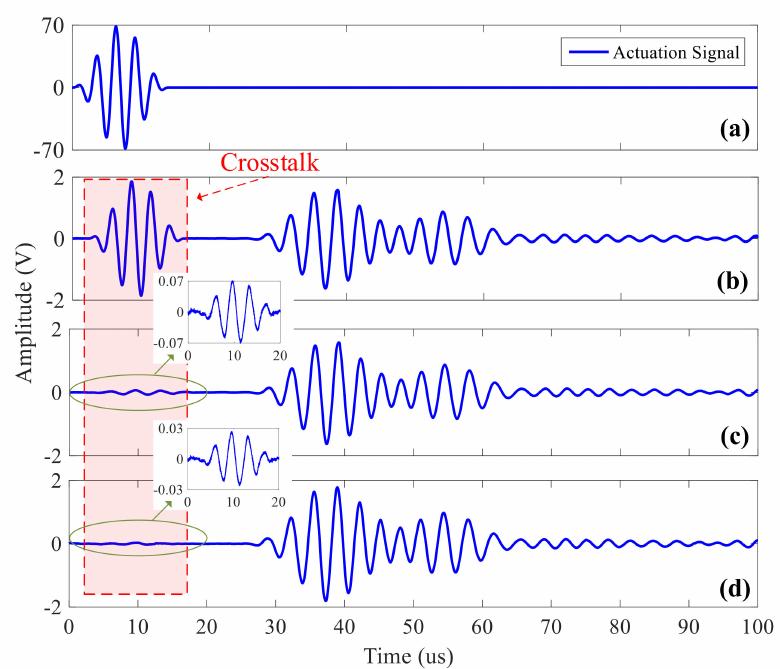
Figure 6. Comparison diagram with the primary attenuator and the secondary attenuator: ( a ) 250khz actuation signal; ( b ) acquisition signal from ex-commercial instrument; ( c ) acquisition signal after being isolated by the primary attenuator; ( d ) acquisition signal after being isolated by the secondary